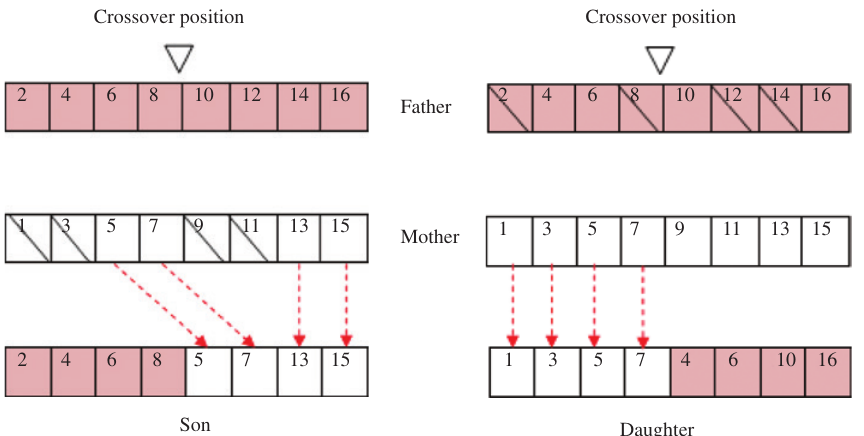
Figure 2: Single Point Crossover